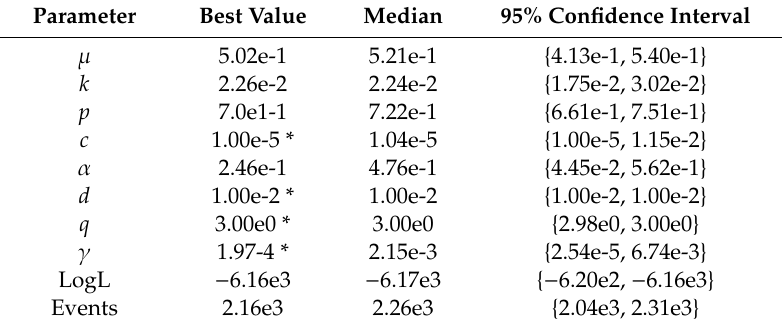
Table 8. Parameter estimates for West Africa. Estimation results for the eight parameters of the ETAS model, the log likelihood and the number of events for the West Africa conflict catalog. Estimates marked with a * are at, or very close to, their constraint values. The best estimate, that is, the estimate of the run with the highest log likelihood, is given for each parameter. Furthermore, the median and the 95% confidence intervals are given.